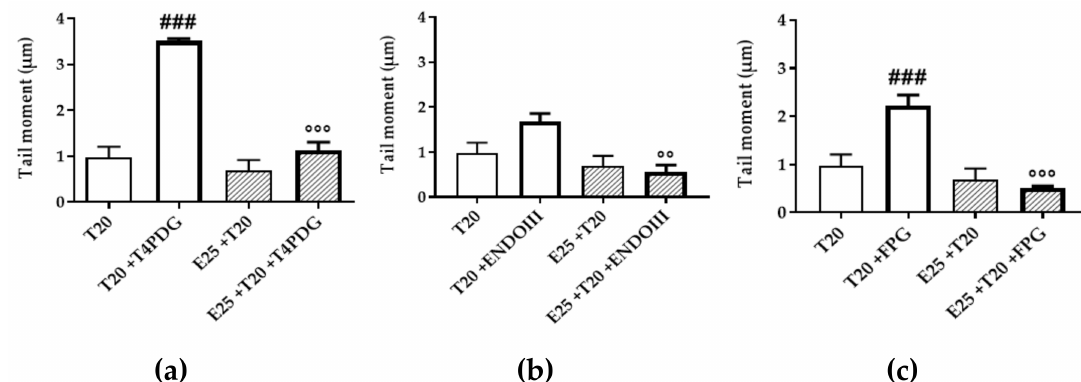
Figure 7. Characterization of genotoxic damage induced by UV-A, and mERC extract’s role. Modified Comet assay measured direct DNA damage using ( a ) T4 PDG enzyme recognizing CPDs; indirect i.e., oxidative damage was identified by ( b ) ENDO III for oxidized pyrimidines or ( c ) FPG for oxidized purines. HMEC-1 cells were treated for 1 h with mERC (25 µ g / mL, E25) and exposed to 20 J / cm 2 UV-A (T20). Results are expressed as mean of medians ± SEM, n = 3. Statistical analysis: One-Way ANOVA with Bonferroni’s post hoc analysis. ### p < 0.001 vs. T20, ◦◦ p < 0.01, ◦◦◦ p < 0.001 vs. T20 + enzyme.